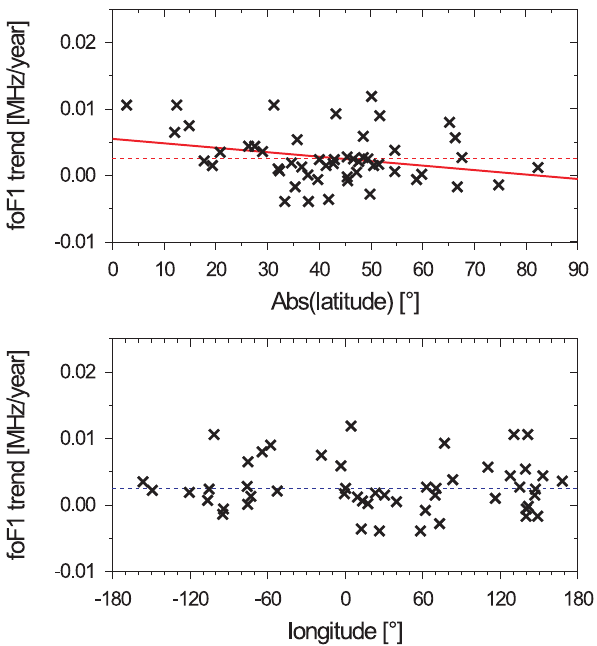
Fig. 10. foF1 trends in dependence on the absolute value of the latitude of the individual stations (upper part) and on the longitude of these stations (lower part). The dashed lines characterize the mean global foF1 trend, the full red line in the upper part is the best linear fit through the individual trend values.